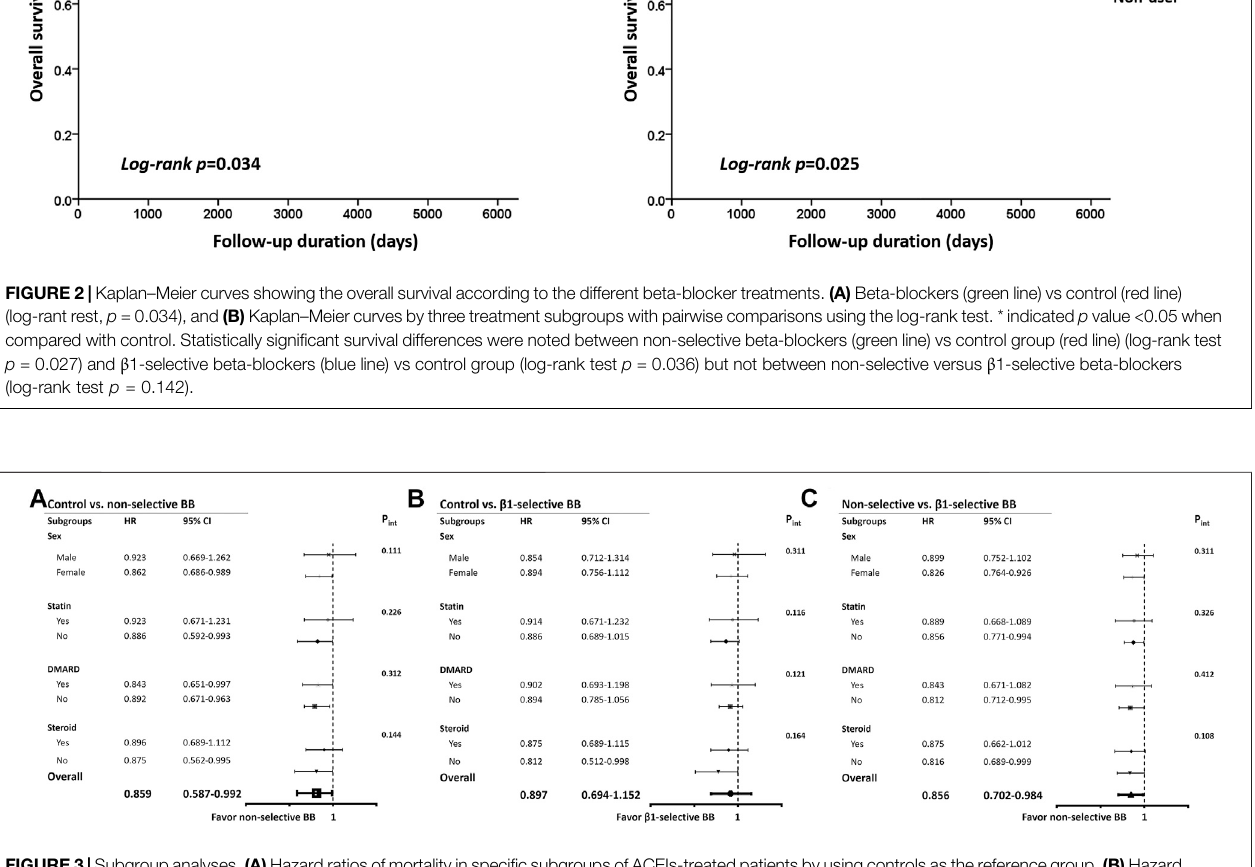
FIGURE3| Subgroupanalyses. (A) Hazard ratiosofmortalityinspeci fi csubgroupsofACEIs-treatedpatientsbyusingcontrolsasthereferencegroup. (B) Hazard ratiosofnew-onsetAFinspeci fi csubgroupsofARBs-treatedpatientsbyusingcontrolsasthereferencegroup. (C) Hazardratiosofnew-onsetAFinspeci fi csubgroups of ACEIs/ARBs-treated patients by using controls as the reference group. Abbreviations: ACEIs, angiotensin converting enzyme inhibitors; ARB, angiotensin receptor blockers; HR, hazard ratio; CI, con fi dence interval; CVD, cardiovascular disease (combination of coronary artery disease, ischemic stroke, hemorrhagic stroke, peripheral artery disease); CHF, congestive heart failure; DM, diabetes mellitus; HTN,